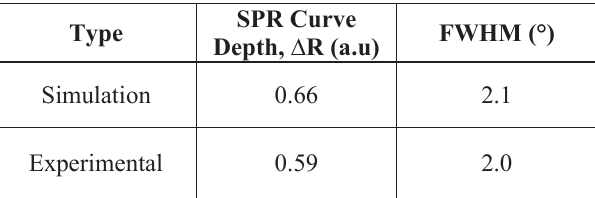
Fig. 9. Comparison of SPR curves of experimental and simulation results with the presence of gold thin layer deposited on the hypotenuse side of prism with thickness of 50nm. Table 2. Summarization of SPR curve depth and